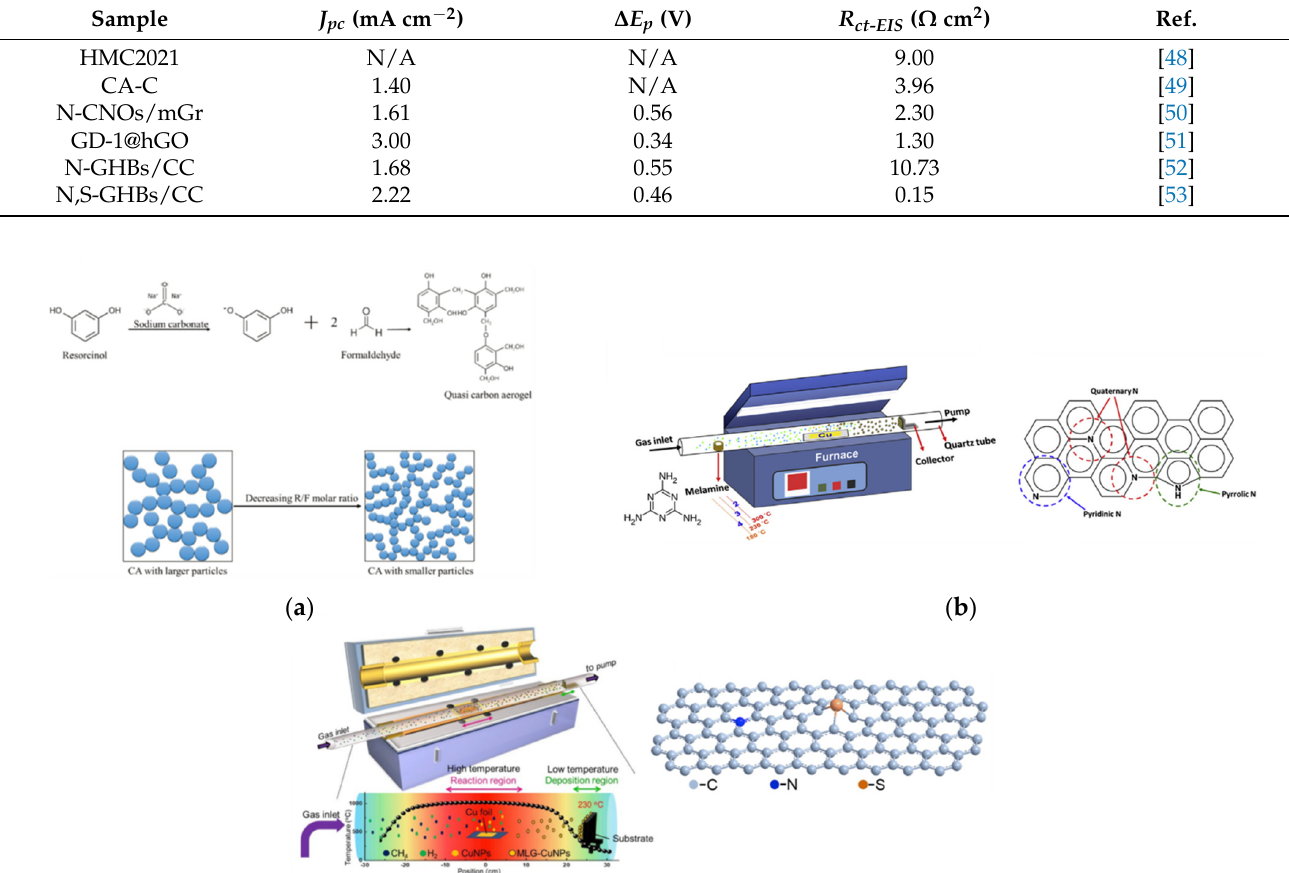
Table 2. The electrochemical parameters of various carbon materials CEs under I − /I 3 − redox couple. Sample